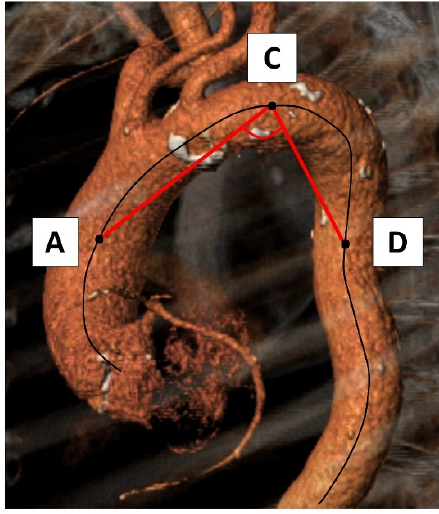
Figure 5. Evaluation of the aortic apex angle. For assessment of the aortic apex angle the center points of the ascending (A) and descending aorta (D) at the mid-level of the right pulmonary artery flow were defined as well as the most cranial point (C) on the centerline (= curved black line) in the aortic arch expressing the apex of the arch. The angle between the lines CA and CD expresses the aortic apex angle.